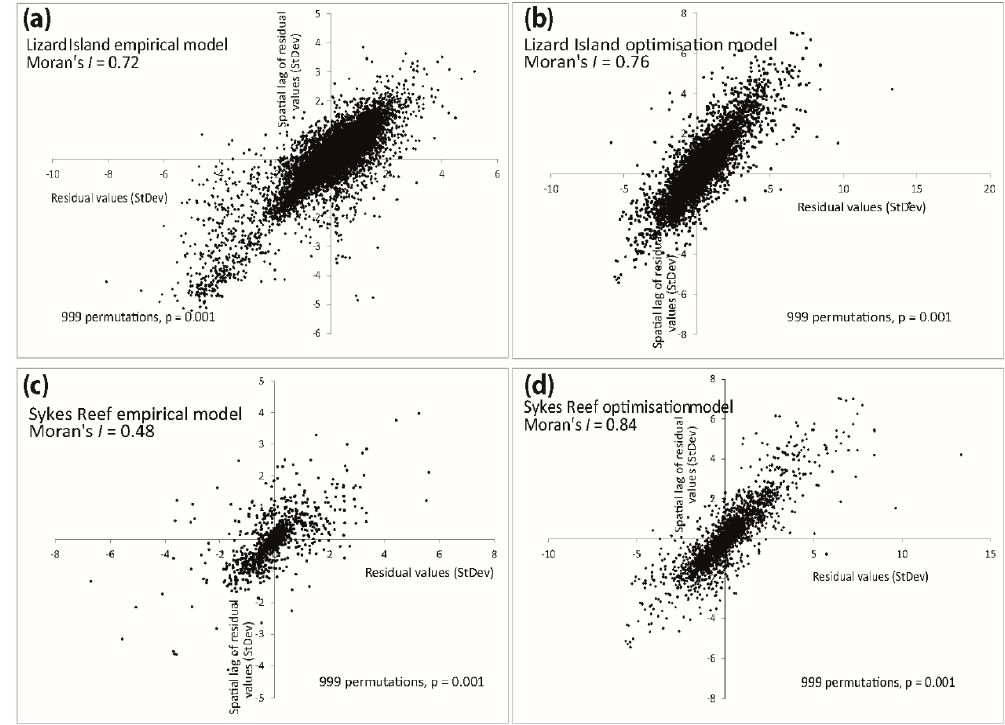
Figure 4. Spatial autocorrelation of residuals from the bathymetric models, as depicted in plots of the residual values (x-axis) against a spatial lag of the residual values (y-axis) (from left to right, top to bottom): ( a ) Lizard Island empirical model; ( b ) Lizard Island optimisation model; ( c ) Sykes Reef empirical model; ( d ) Sykes Reef optimisation model. Global Moran’s I estimates of autocorrelation are provided. Axes relate to the standard deviation of true values and indicate the absolute magnitude of the error term.